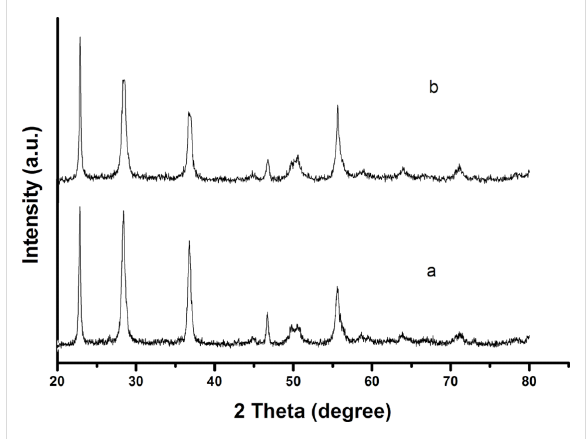
Figure 1: XRD patterns of Ta 2 O 5 nanoparticles obtained from (a) Ta(OEt) 4 (OOCCHCl 2 ) and (b) Ta(O n -Bu) 4 (OOCCHCl 2 ) calcined at 750 °C for 4